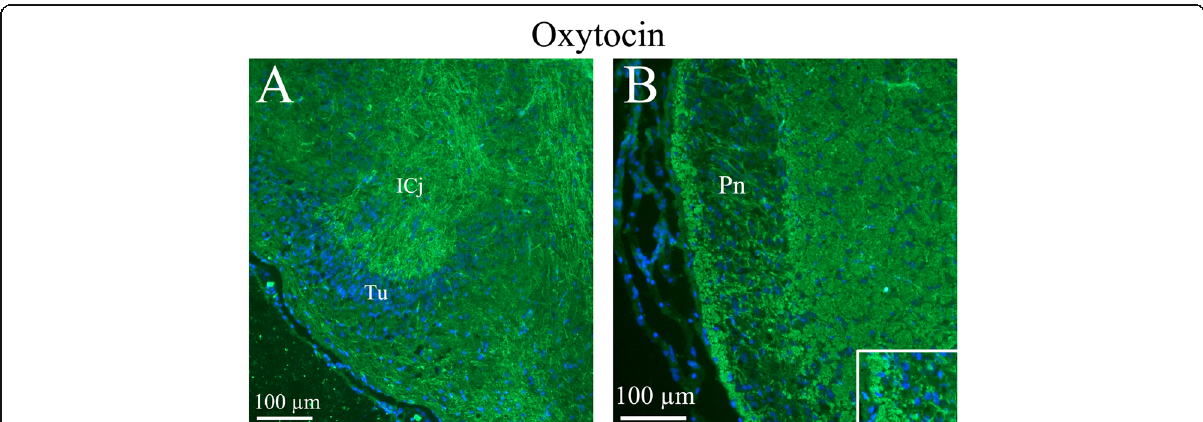
Fig. 11 Oxytocin immunohistochemistry of the Islands of Calleja and the Pons. a . Thin slender processes in the Islands of Calleja (ICj) plus fibers structures in the surrounding area were oxytocin immunoreactive. b . In the pontine nucleus (Pn), the neurons were surrounded by thin oxytocin positive fibers (insert)